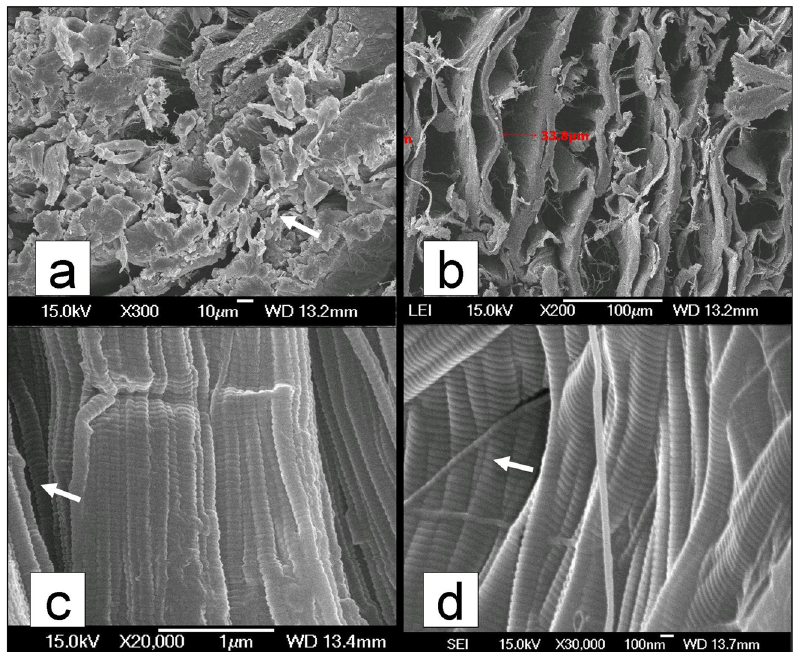
acellular aponeurosis-discission ligament (AADL); c 1, c 2 longitudinal sections and cross sections of an intact aponeurosis after decellular- ization. (magni fi cation ×200)